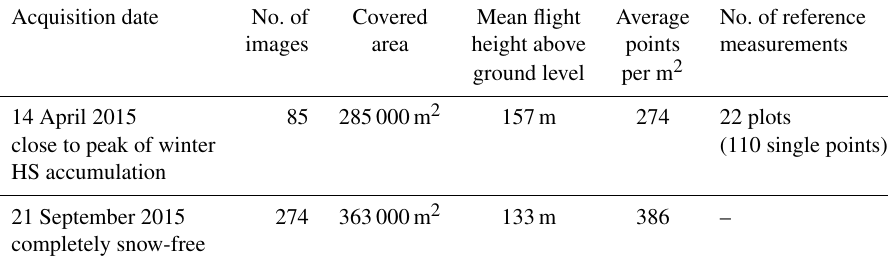
Table 3. Data acquisition parameters for the Brämabühl test